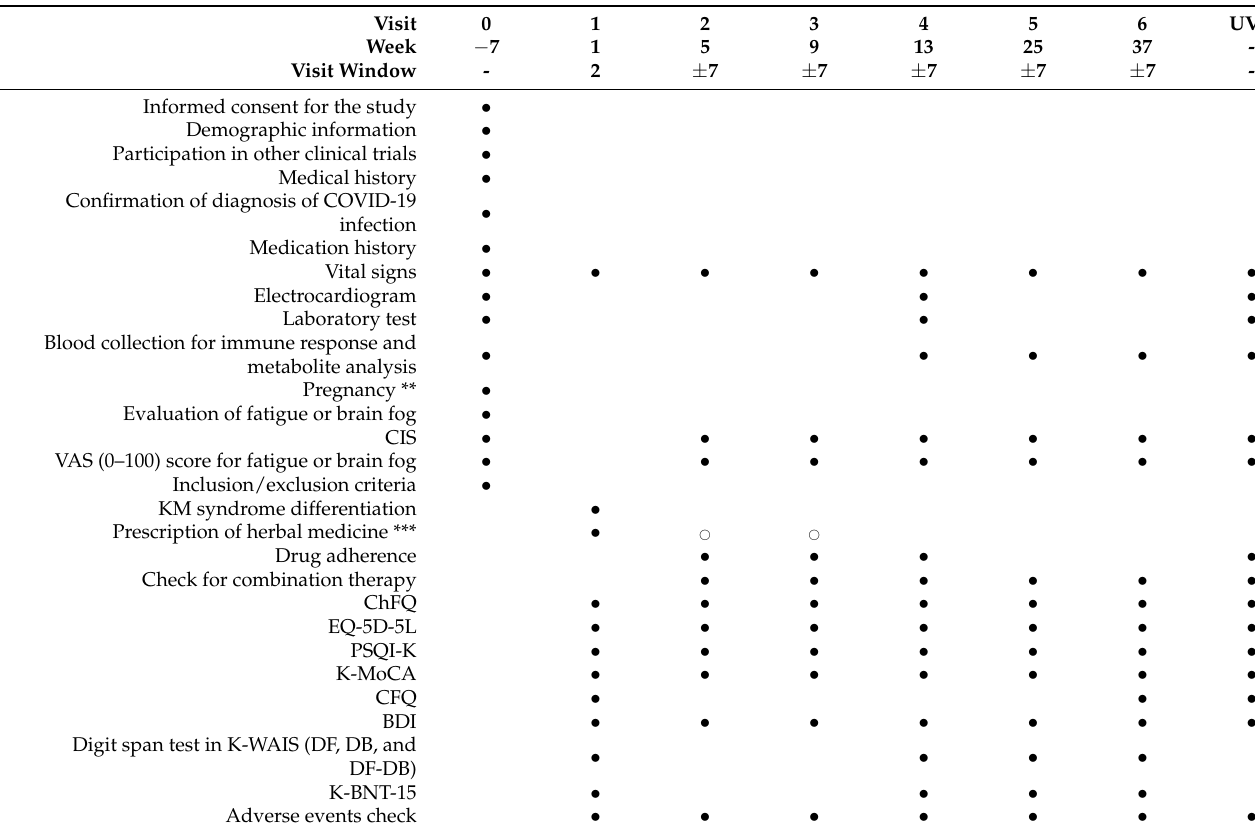
Figure 1. Flow diagram and schedule. Table 1. Schedule summary.